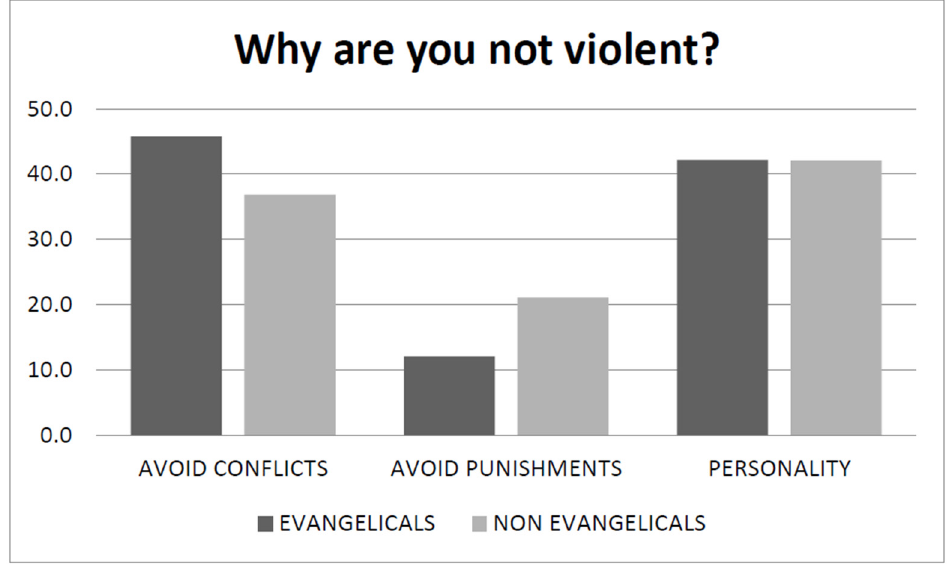
Figure 1. Why are you not violent? n = 83, n = 76.